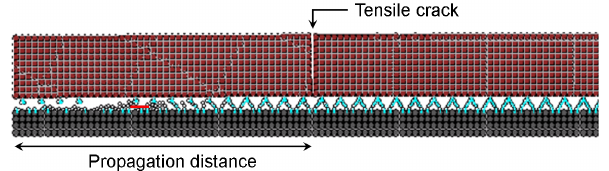
Figure 9. Snapshot of a PST with fracture arrest due to tensile crack opening in the slab induced by slab